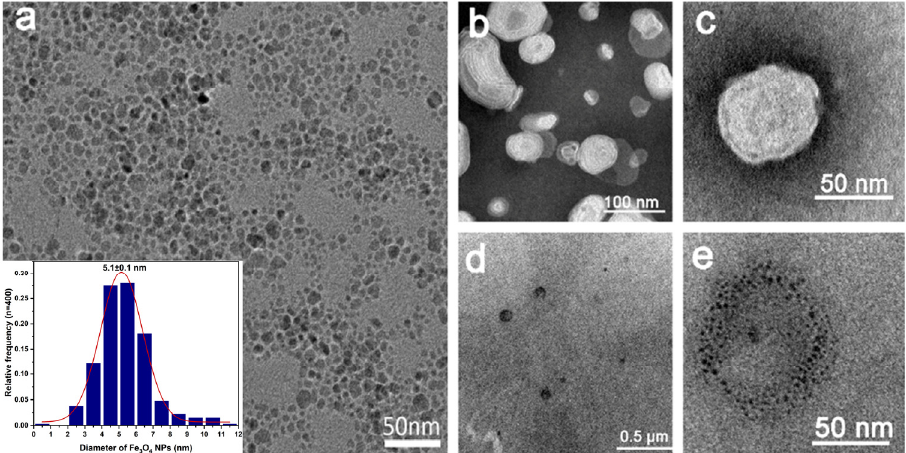
Figure 5. Characterization of Fe 3 O 4 @OA and composite liposomes. ( a ) TEM images of Fe 3 O 4 @OA and Inset: Size distribution of Fe 3 O 4 @OA (average diameter = 5.1 ± 0.1 nm). ( b , c ) Liposome@ Fe 3 O 4 with negative staining. ( d , e ) Liposome@Fe 3 O 4 without negative staining. Table 1. Elements content of Fe 3 O 4 @OA NPs.